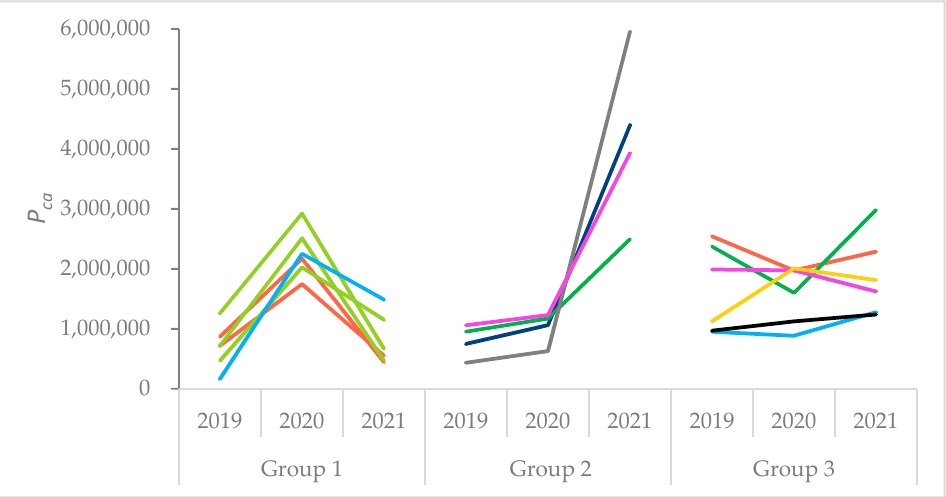
Figure 5. Pollen production per catkin ( P ca ) ( y -axis) in 2019–2021 assessed for the selected non-topped trees at the seed planation Wildberg and categorized in three groups with similar temporal behavior. The color of the lines symbolizes trees of the same clone.